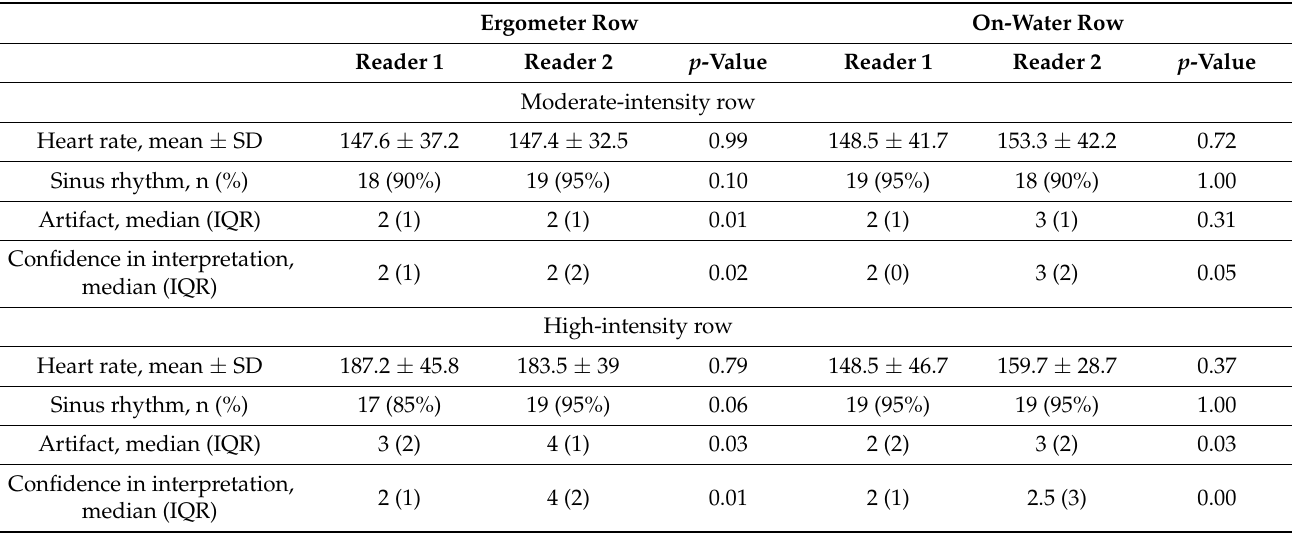
Table 1. Comparisons between readers on ECG interpretations by rowing intensity and condition. Ergometer Row On-Water Row Reader 1 Reader 2 p -Value Reader